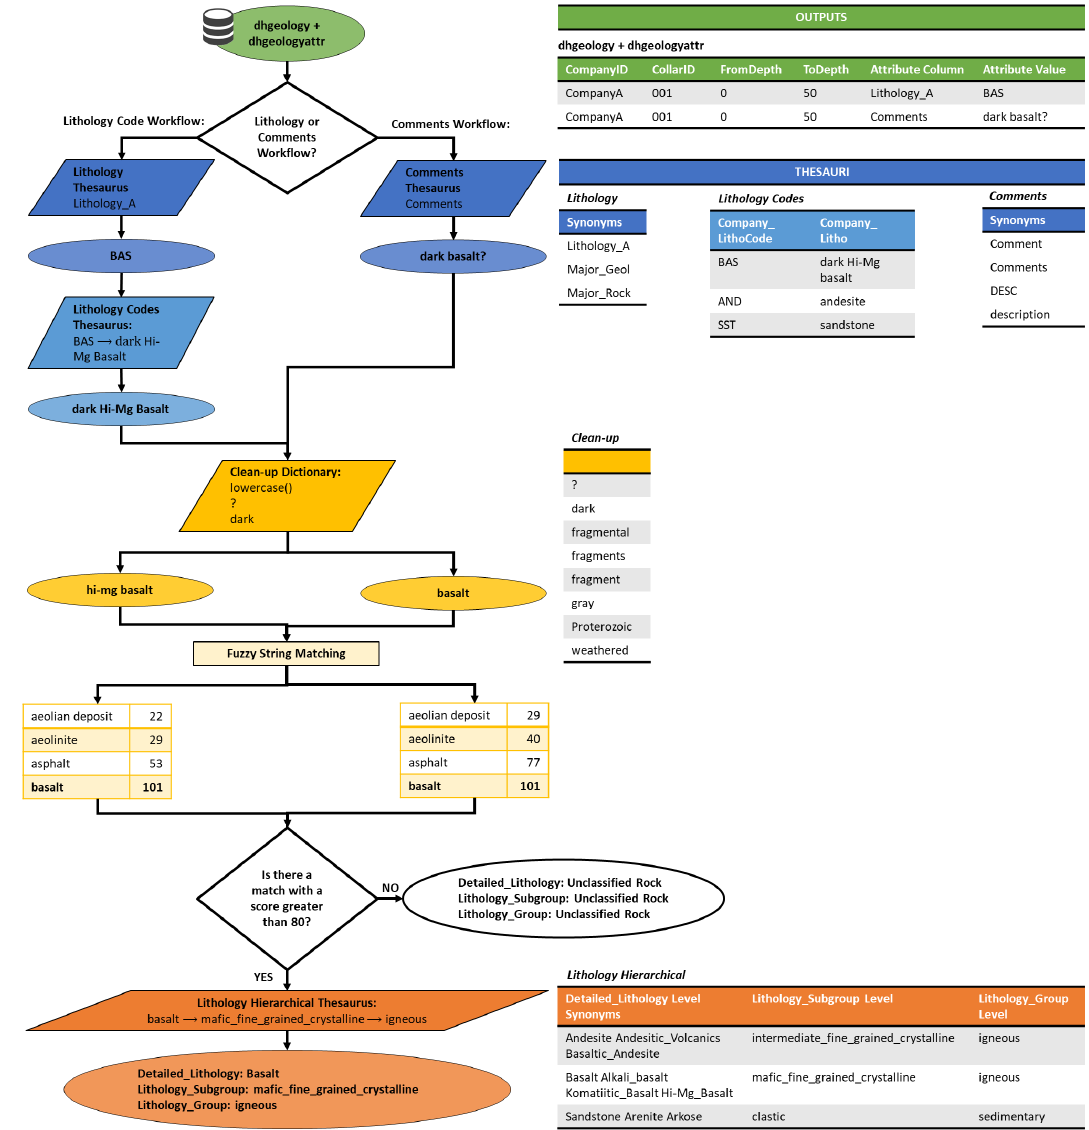
Figure 2. Lithology extraction is done through the Lithology Code workflow and Comments workflow . The values are fetched from the dhgeology and dhgeologyattr table (green) using either the Drill Hole Lithology Thesaurus (blue) and Drill Hole Lithology Codes Thesaurus (light blue) or the Drill Hole Comments Thesaurus (blue). The string fetched is then cleaned prior to the fuzzy string matching using the Clean-up Dictionary (dark yellow). The result is then matched against the Detailed_Lithology level of the Lithological Hierarchical Thesaurus. If there is a match with a score greater or equal to 80, the match is taken and matched with the rest of the columns in the Lithology Hierarchical Thesaurus. If not, it is labelled as unclassified rock.